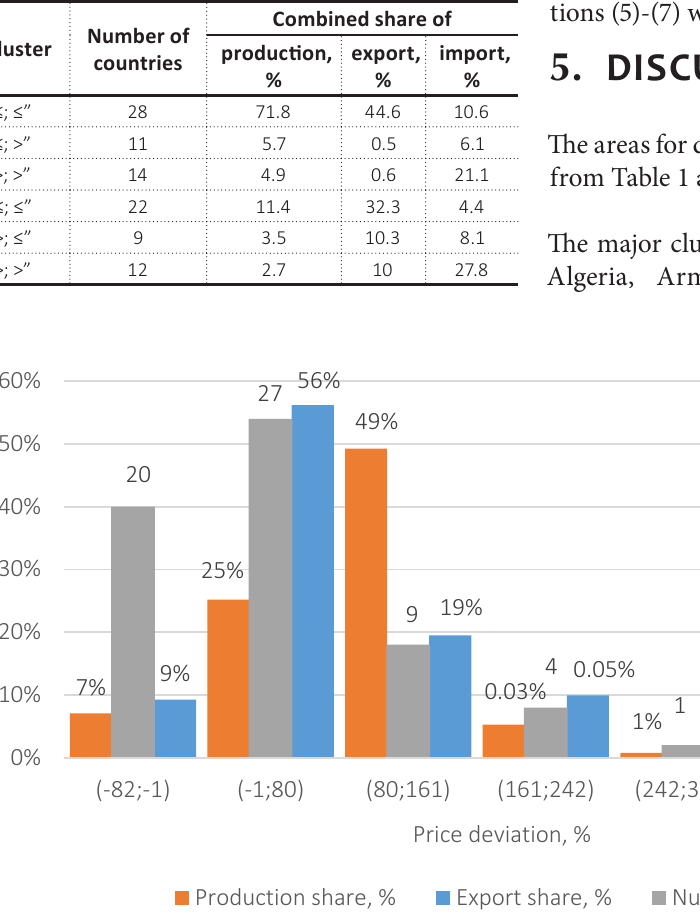
Figure 2. Histogram on deviations between production and export prices for apples